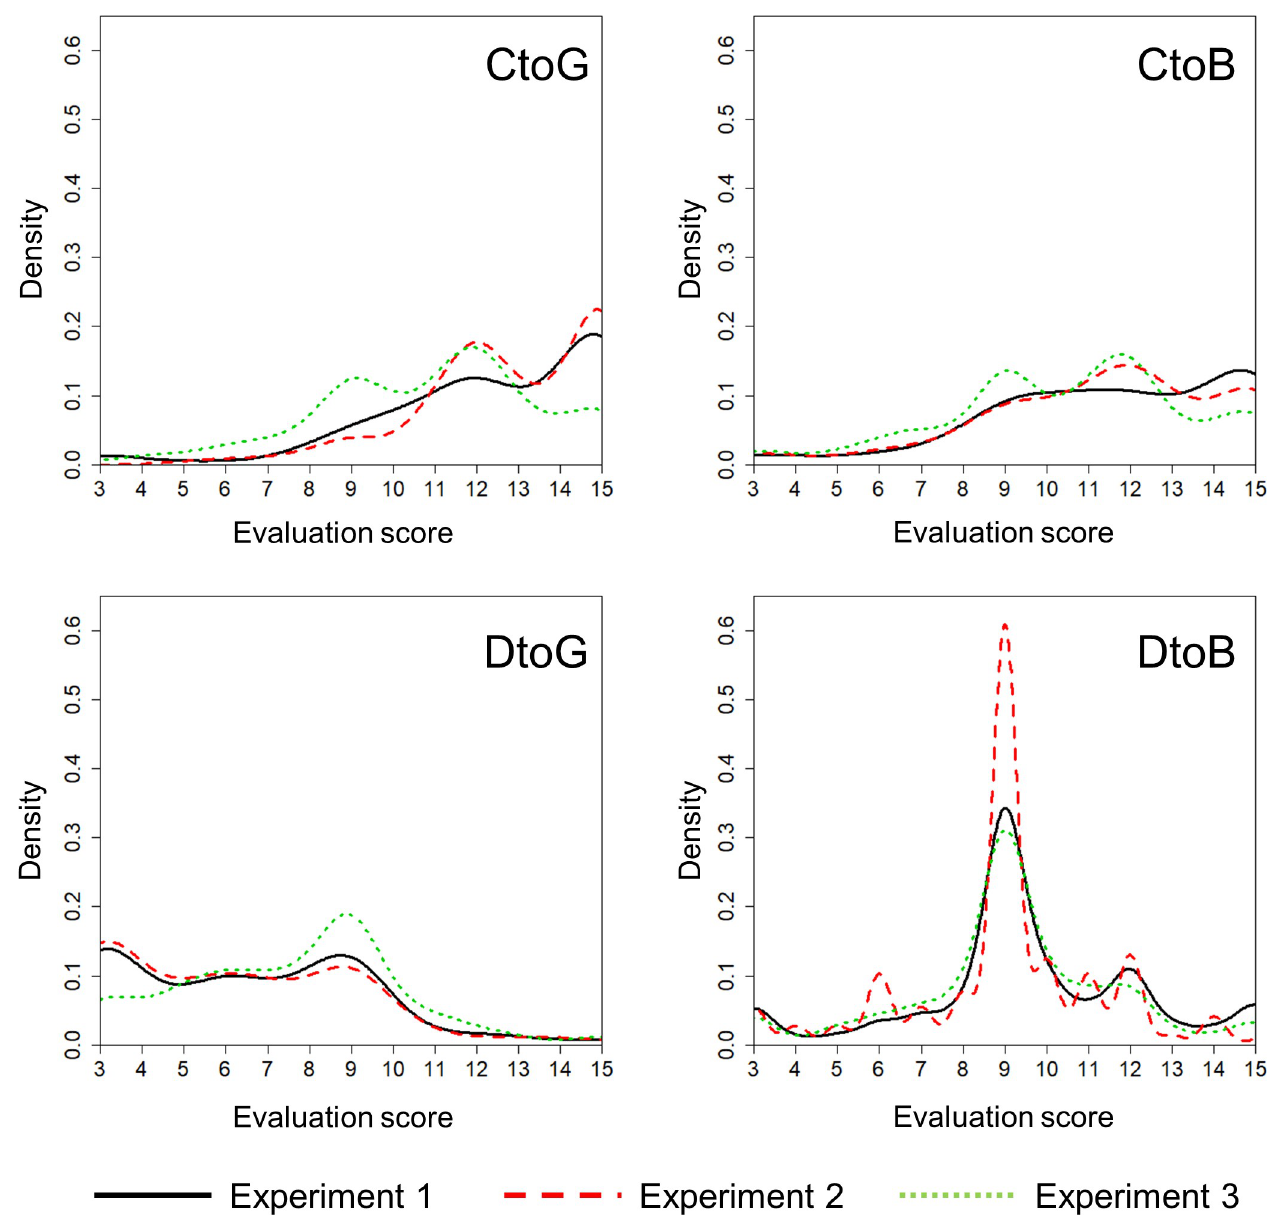
Fig 2. Distribution of evaluation for donors: The horizontal axis shows the evaluation score. The scores were calculated by simply adding together the scores of three statements on a 5-point scale, so it has minimum and maximum values of 3 and 15. The vertical axis shows the density of kernel density estimation. The solid black line, dotted red line, and dotted green line represent Experiments 1, 2, and 3, respectively.